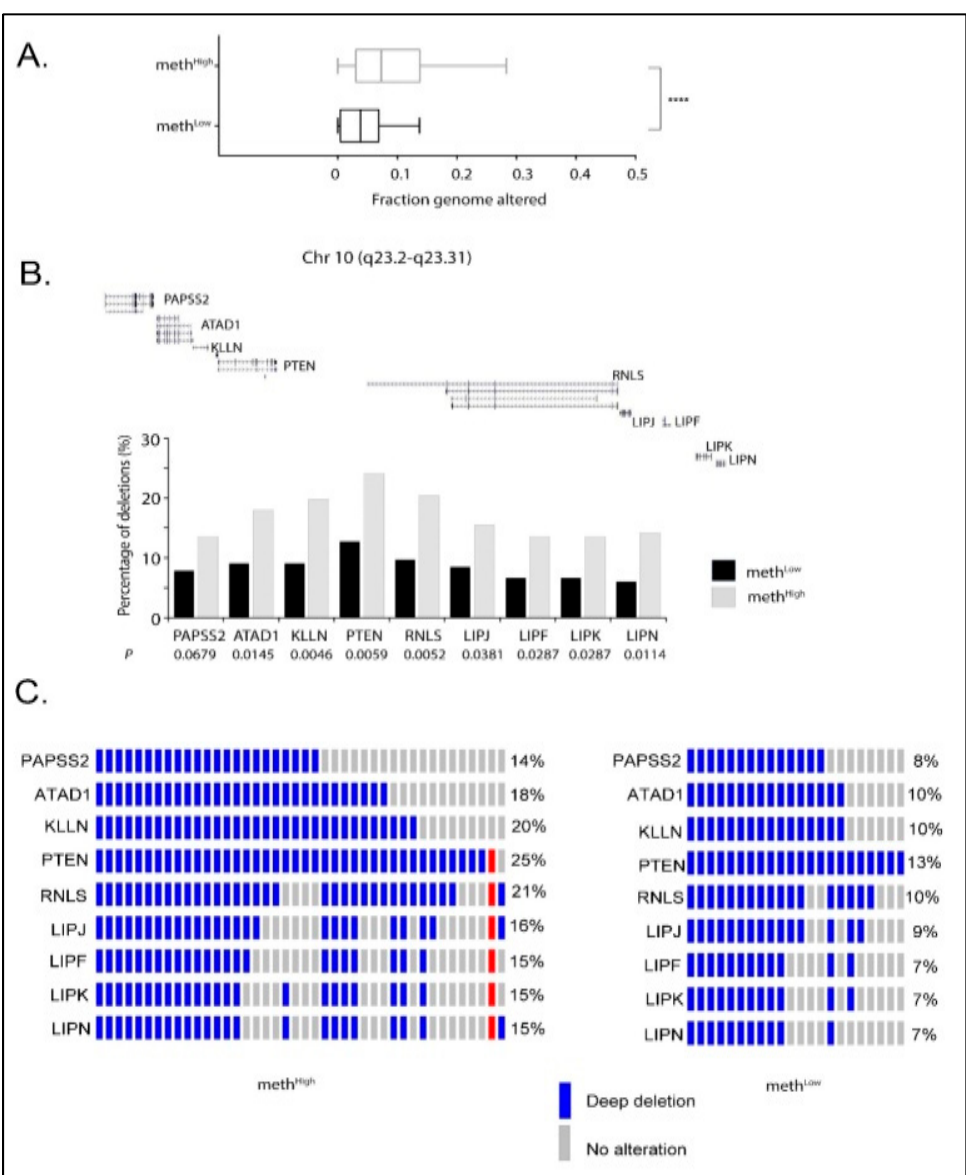
Figure 3. USP44 methylation and its correlation to PTEN deletions in prostate adenocarcinoma patients . ( A ) Fraction of genome altered between meth High and meth Low groups. Data were obtained by TCGA-PRAD (Firehose Legacy). p > 0.0001. ( B ) USP44 promoter methylation and correlation to gene deletions in chromosomal region Chr 10 (q23.2-q23.31). Copy number variation data (CNVs) were obtained by TCGA-PRAD (Firehose Legacy). p values underneath the gene names were calculated with Mann-Whitney test. ( C ) Oncoprints indicating patients with gene deletion events within the chromosomal region Chr 10 (q23.2-q23.31) in meth High (left) and meth Low (right) group. Gene deletion frequencies (%) within the group are indicated on the right side of the oncoprint. Oncoprints were generated through cbioportal using CNV data from TCGA-PRAD (Firehose Legacy) (**** indicates p<0.0001 ).